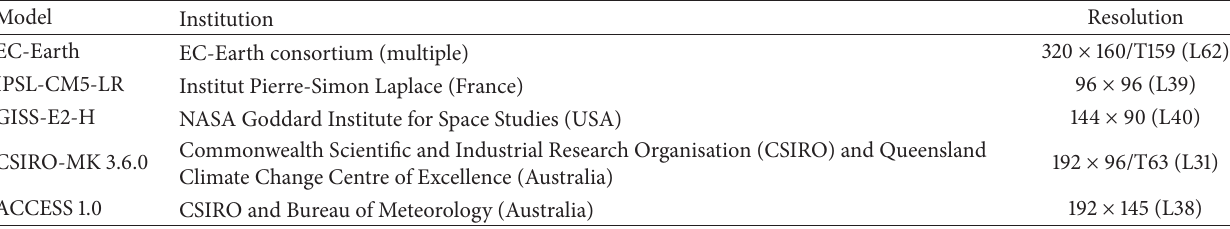
Table 1: List of the CMIP5 models used in this